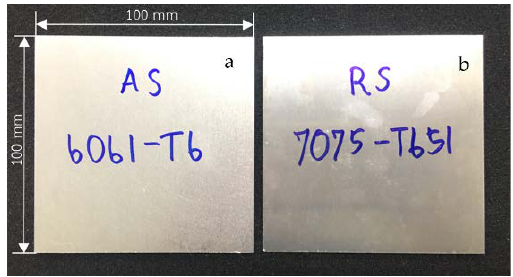
Figure 2. Aluminum plates: ( a ) AA6061-T6; ( b ) AA7075-T651.